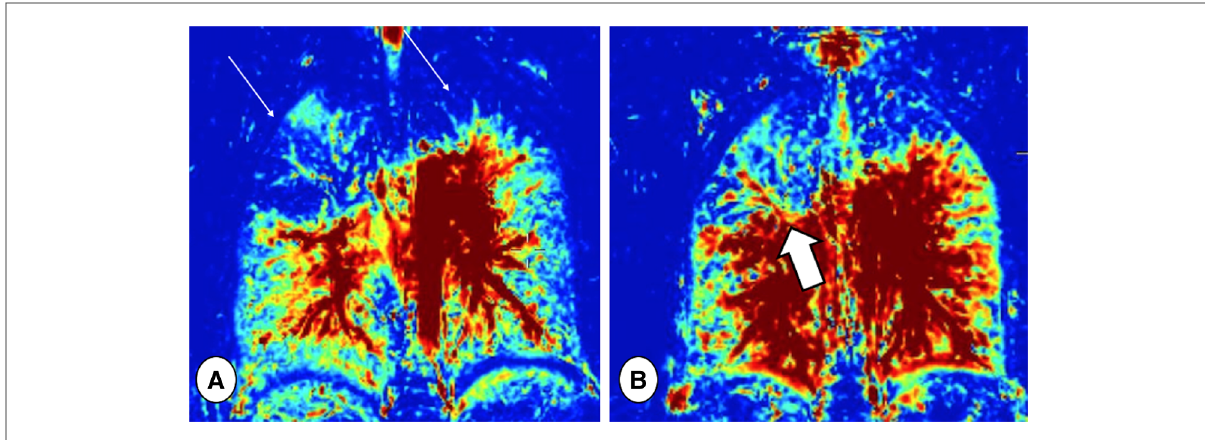
FIGURE 10 Ventilation maps taken before ( A ) and after ( B ) respiratory tract exacerbation treatment in a patient with CF, obtained by Fourier decomposition MRI. Note the ventilation defects in the upper lobes at baseline (thin arrows), which improved after treatment, especially in the right lung (thick